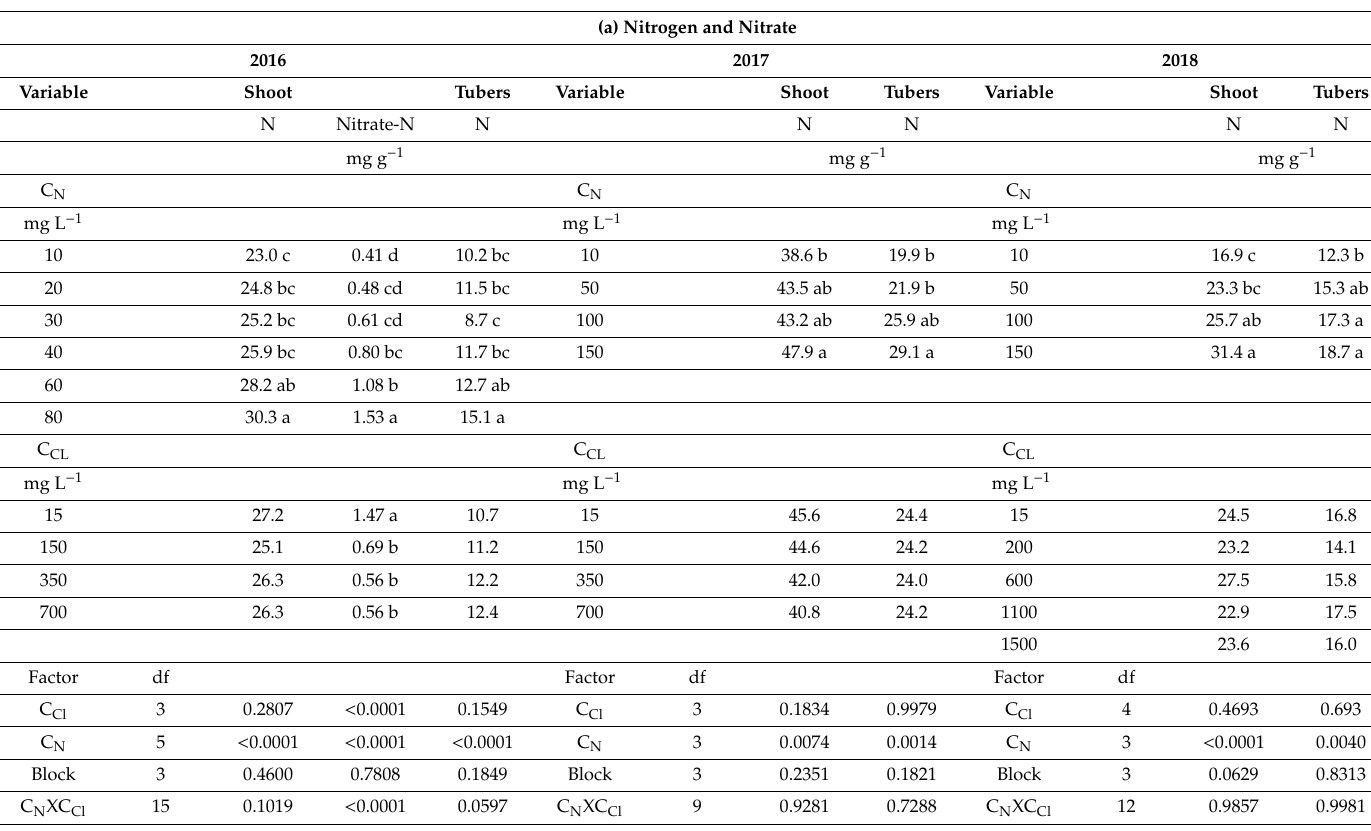
Table 7. The e ff ect of C N and C CL on the concentrations of ( a ) N and nitrate-N, and ( b ) Cl in Potato leaves and tubers. Probability of F values for C N , C Cl , Block factors, and the interaction of C N and C Cl were determined using the two-way ANOVA procedure of JMP 14. Di ff erent letters on the right side of values indicate significant di ff erence between treatments (HSD) at p < 0.05 by the Tukey–Kramer honestly test. No letters are presented when no significant di ff erence was